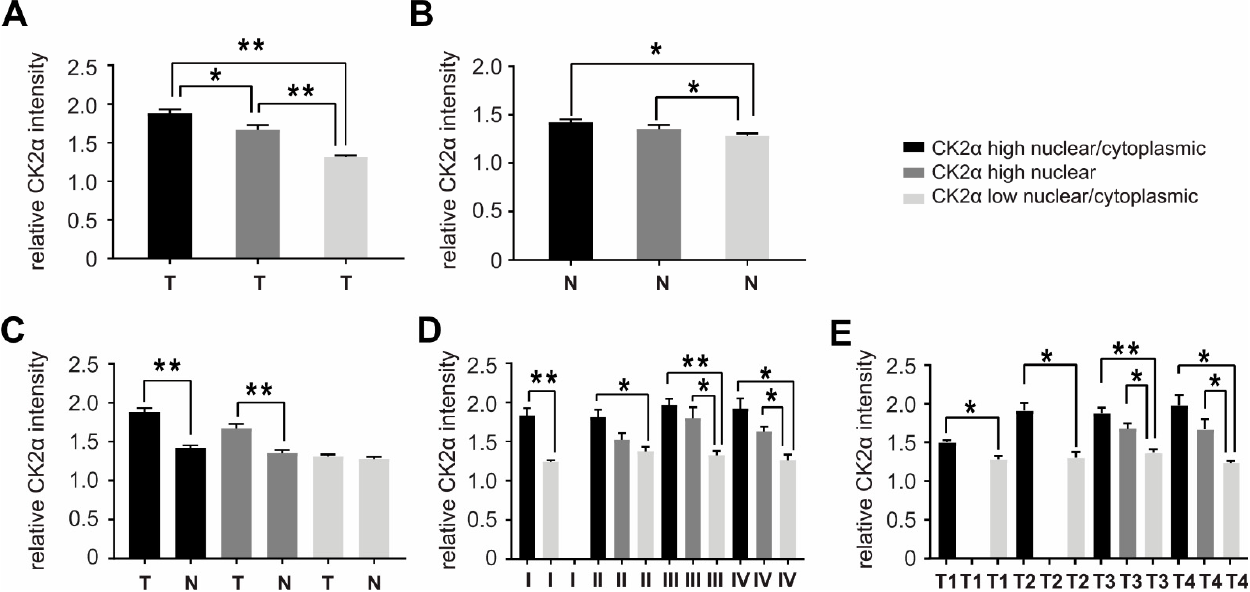
Figure 2. CK2 α expression is significantly enhanced in a high proportion of CRCs. The intensity of CK2 α expression in our MLH1-proficient cohort was determined by immunohistochemistry, analyzed using ImageJ and then compared in CRC tissue and corresponding normal adjacent mucosa. Tumors were grouped by (i) high nuclear/cytoplasmic, (ii) high nuclear or (iii) low nuclear/cytoplasmic CK2 α‐ expressing CRCs. CK2 α intensities were compared ( A ) only within all tumor tissues (T), ( B ) only within all normal mucosa (N), ( C ) between CRCs and the corresponding normal adjacent mucosa, respectively. Tumor tissues with high nuclear/cytoplasmic, high nuclear, or low nuclear/cytoplasmic CK2 α expression were then divided and compared between different ( D ) UICC and ( E ) TNM stages (additional information see Table S2). Statistical significance was assessed by GraphPad Prism 7 for Windows, Version 7.04 (GraphPad Software, La Jolla, CA, USA). The data shown are means ± SEM, p ‐ values are two ‐ sided and values <0.05 (*) or <0.01 (**) are considered statistically significant.